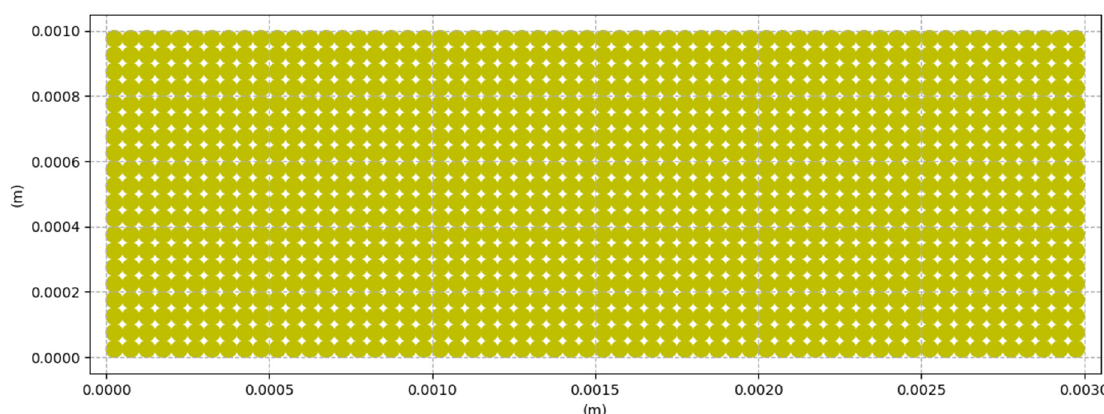
Figure 5. Distribution of DEM particles in the powder bed.